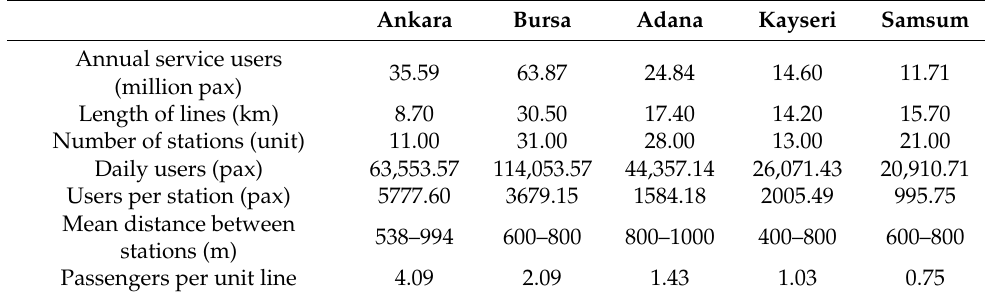
Table 6. Data for Turkey, based on